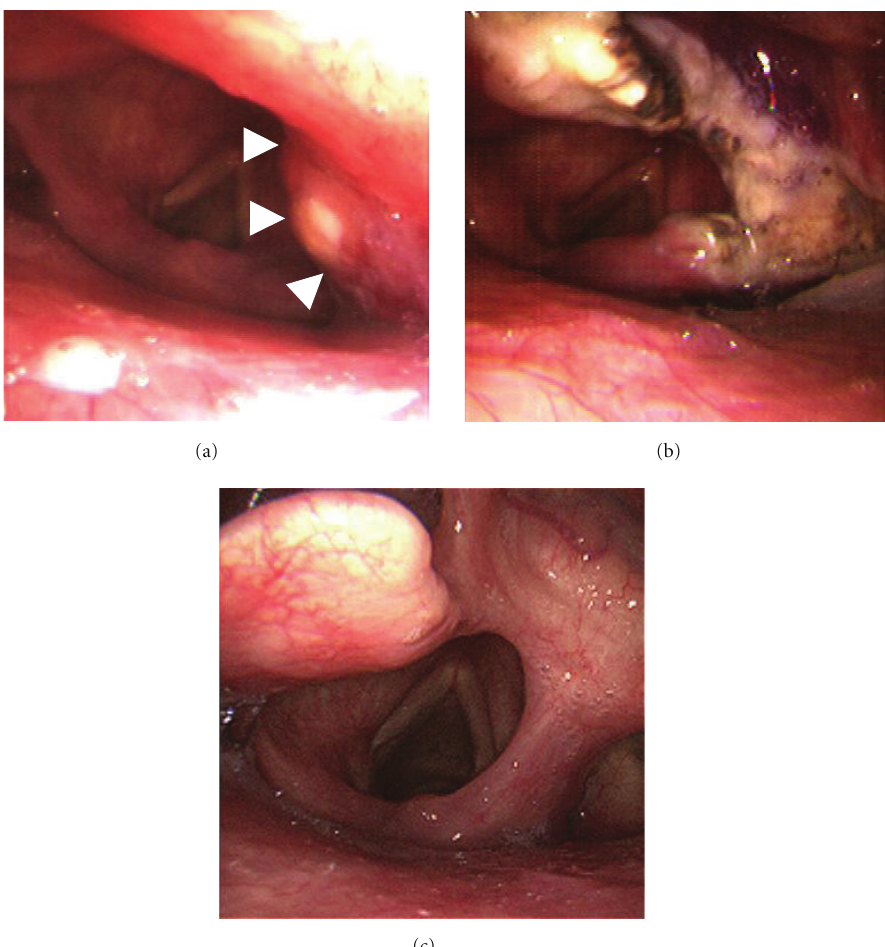
Figure 1: Laryngeal findings. (a) Before surgery, a somewhat uneven tumor in the submucosa can be seen on the right-hand side of the laryngeal surface of the epiglottis (arrow). (b) Four days after surgery. The right half of the epiglottis has been resected. The resection stump is covered with the white scab. (c) Two years after surgery. The wound has epithelialized well.